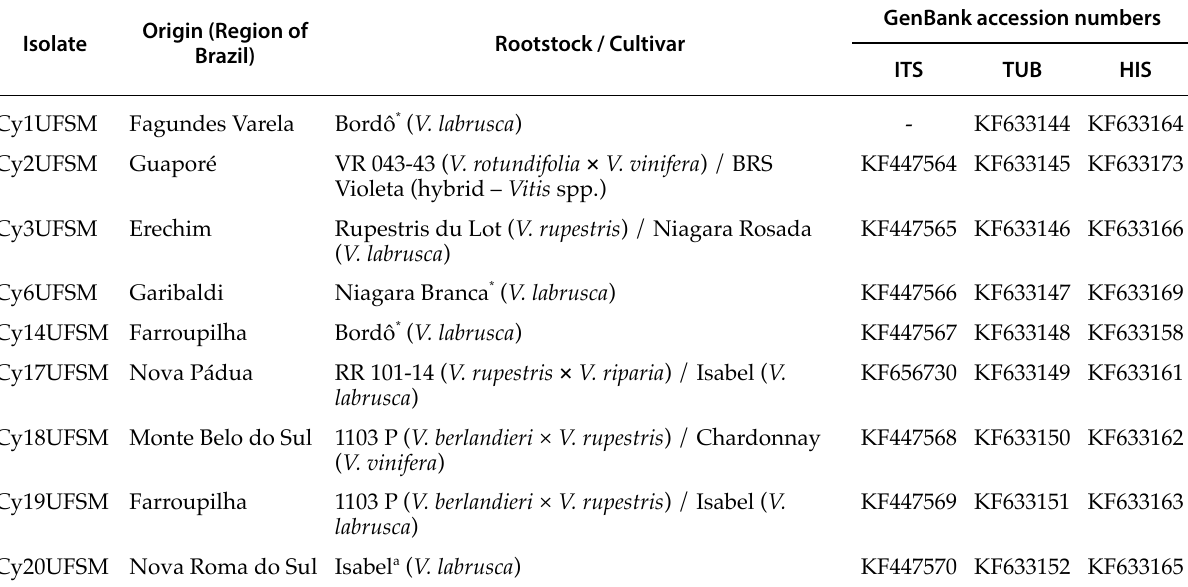
Table 1. Details of the Campylocarpon pseudofasciculare isolates studied. Origin (Region of Isolate